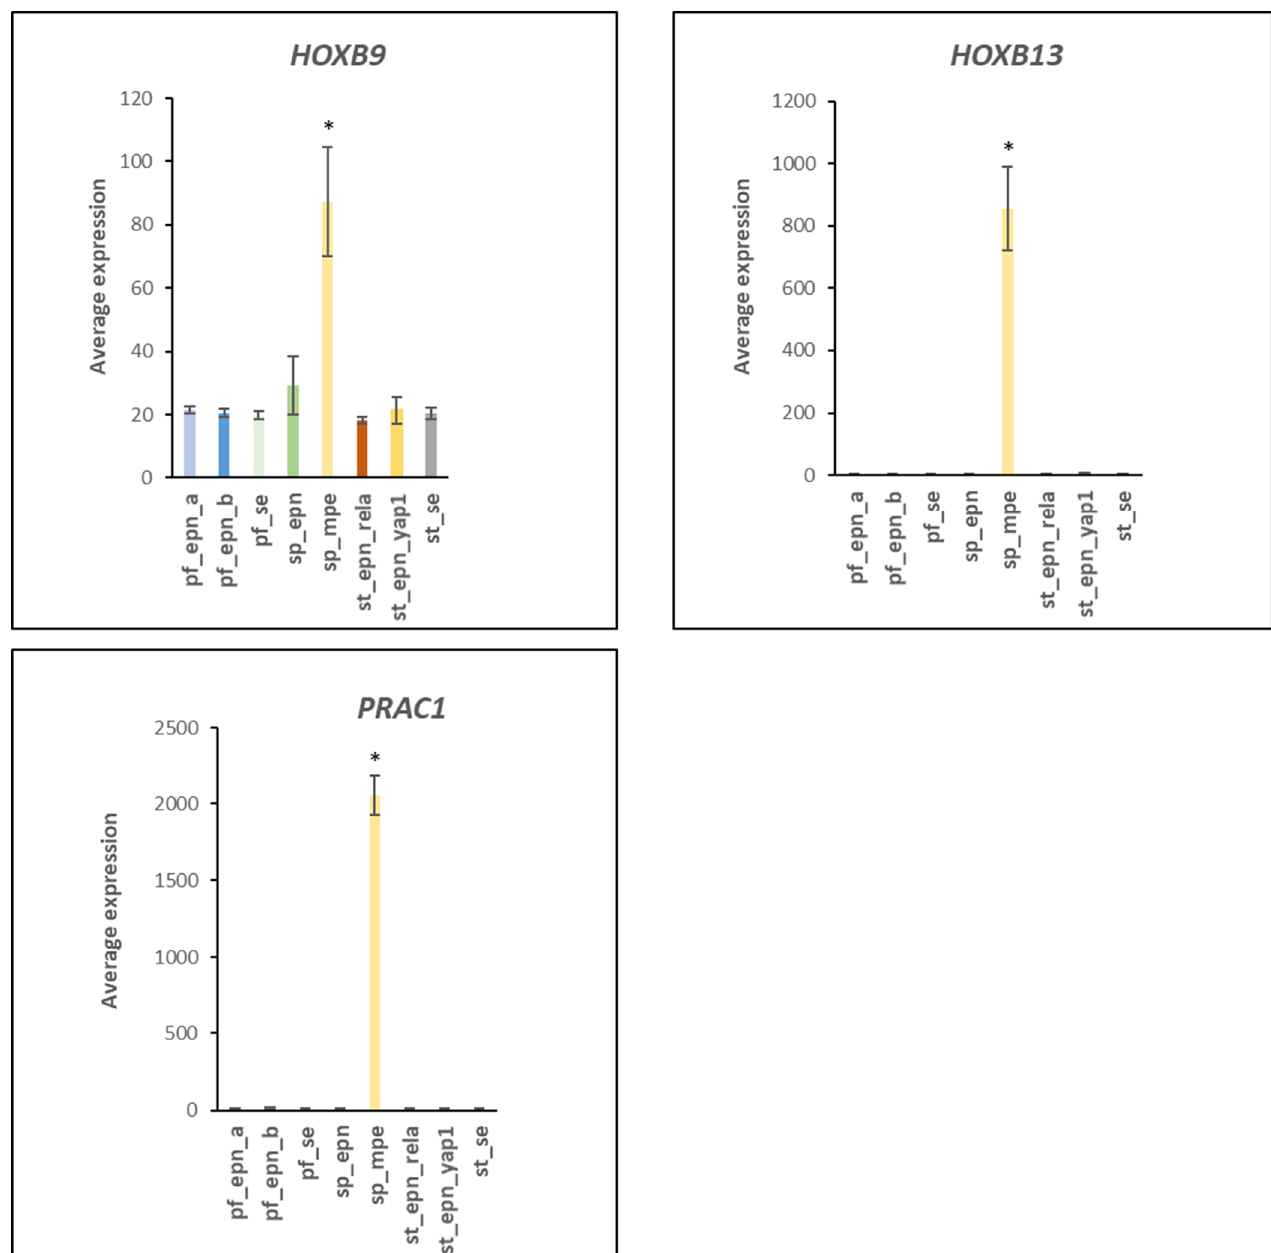
Figure 11. Gene expression in the homebox cluster of chromosome 17 (17q21.32) in the SPE_MPE subtype (by Anova, HOXB9 , F = 25.31, p = 5.26 × 10 − 25 ; HOXB13 , F = 160.28, p = 1.21 × 10 − 78 ; PRAC1 ,